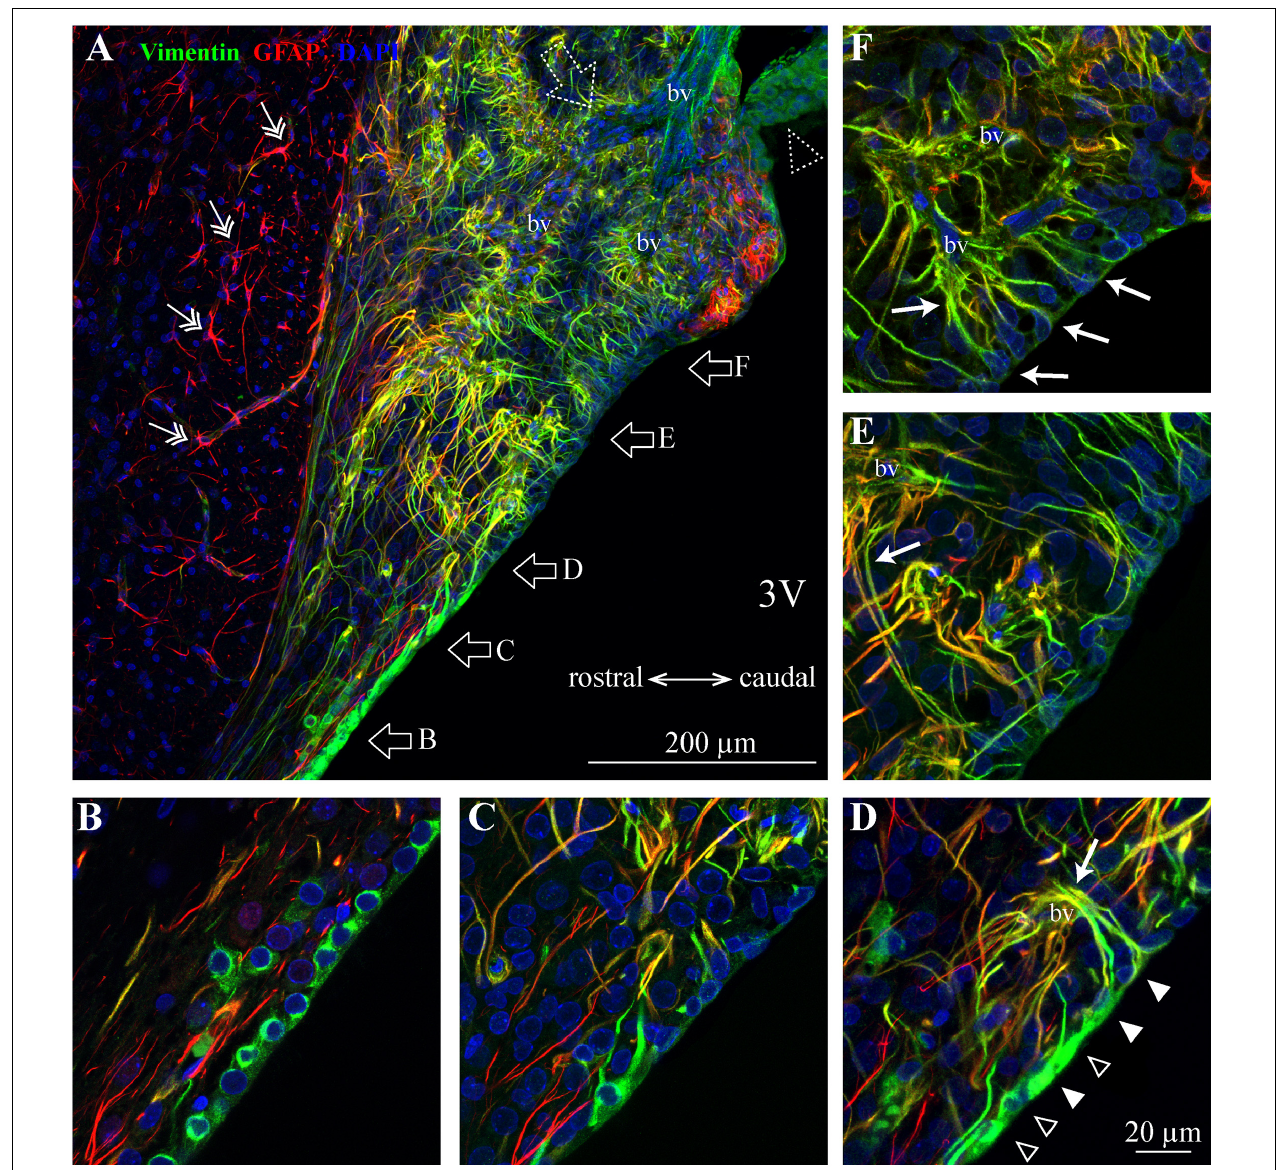
FIGURE 4 | Distribution of SFO ependymocytes, tanycytes and astrocytes in the sagittal plane. (A) A low magnification confocal image shows the distribution of vimentin (green), glial fibrillary acidic protein (GFAP, red), and DAPI in a mid-sagittal SFO section (lateral coordinate –0.10 mm). Note GFAP-positive classical stellate astrocytes are only present outside the SFO (double arrow). (B–F) Higher magnification images showing ventral portions of the SFO corresponding to areas in panel (A) (open arrows). The ventricular wall of the SFO created by ependymocytes in the rostral part (B) , which are gradually replaced by tanycytes [ (D) , ependymocytes open arrowheads, tanycytes full arrowheads]. The caudal part of the SFO ventricular wall is created by cell bodies of tanycytes (E,F) . Note tanycytic processes projecting toward capillaries [white arrows in panels (D–F) ]. Note subfornical artery entering from the caudal part of the SFO and passing through the center of the nucleus (open dotted arrow). The most caudal aspect of the SFO is connected to the choroid plexus (dotted open arrowhead). 3V, third ventricle; bv, blood